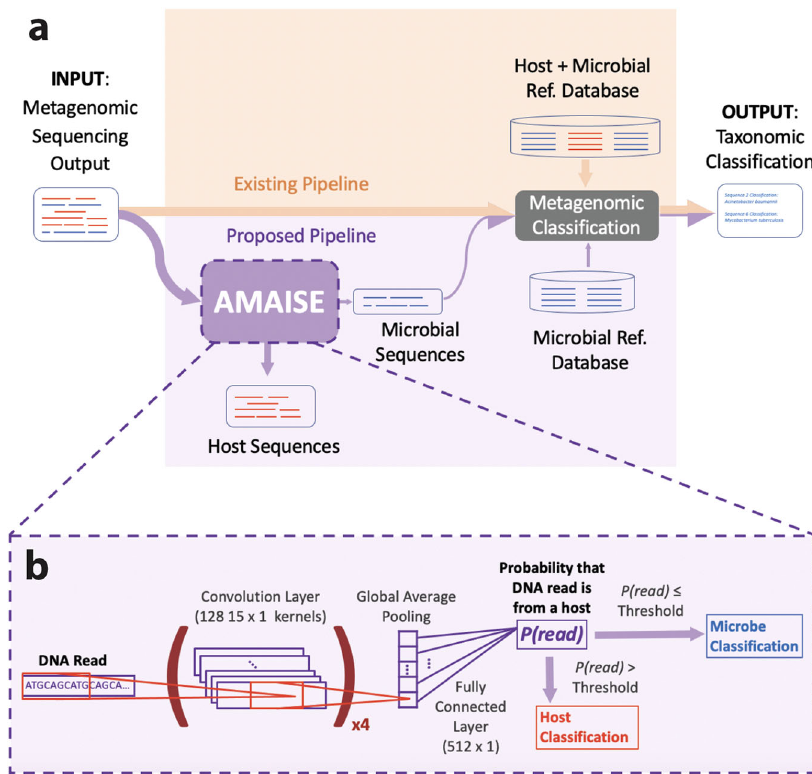
Fig. 1 An overview of the AMAISE work fl ow. a A comparison of the metagenomic classi fi cation pipeline with (purple) and without AMAISE (orange). In standard metagenomic community identi fi cation, reads are sent to a classi fi cation method that uses host and microbial references to assign a taxonomic label to each read. In our pipeline, we propose to import the reads into AMAISE, which then separates host from microbial reads. This smaller microbial fraction is sent to a classi fi cation method that only needs microbial references to assign taxonomy. b AMAISE is composed of four convolutional layers followed by a global average pooling layer. For each read input, AMAISE outputs a probability that the read is host. If the probability is higher than the prede fi ned threshold, the read is considered to be from a host. Else, the read is considered to be from a